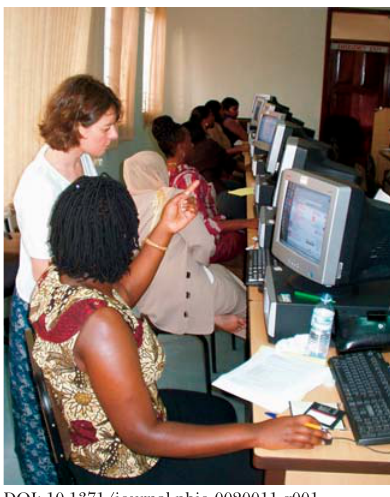
Figure 1. A Workshop on the Use of ICTs to Report on the Science of HIV/AIDS This workshop was held in Kampala, Uganda, in April 2003. (Photograph: